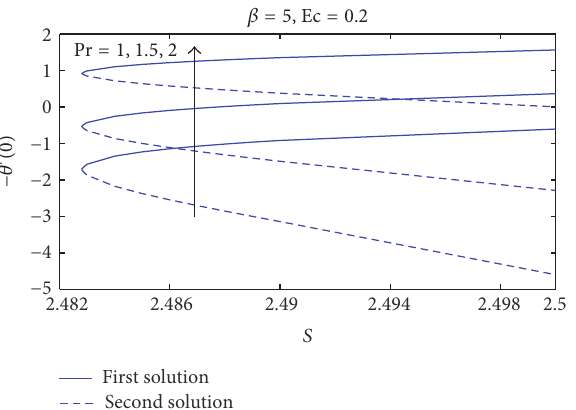
Figure 7: The streamline of the flow for second solution with 𝐿 = 1 .